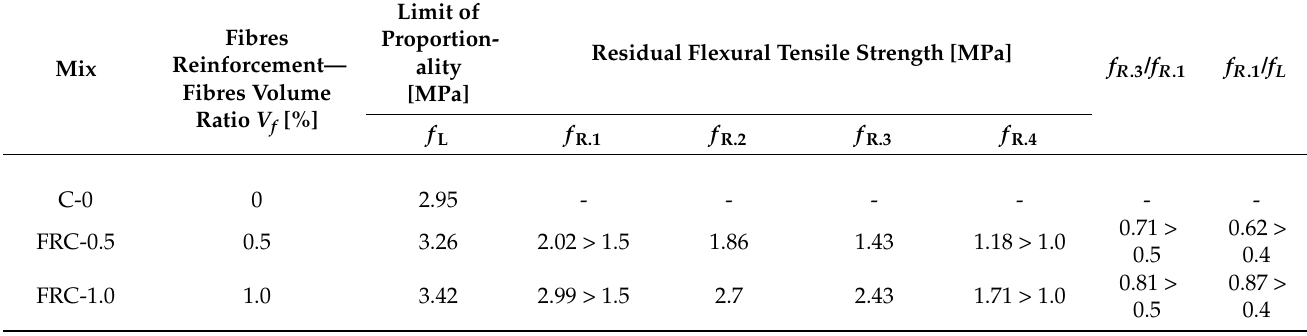
Table 6. Three-point flexural tensile tests—mean